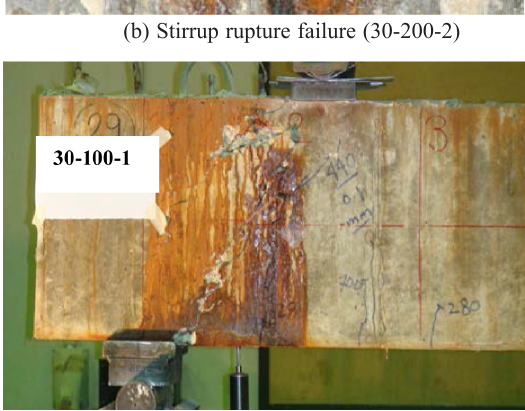
Fig. 9. Failure modes